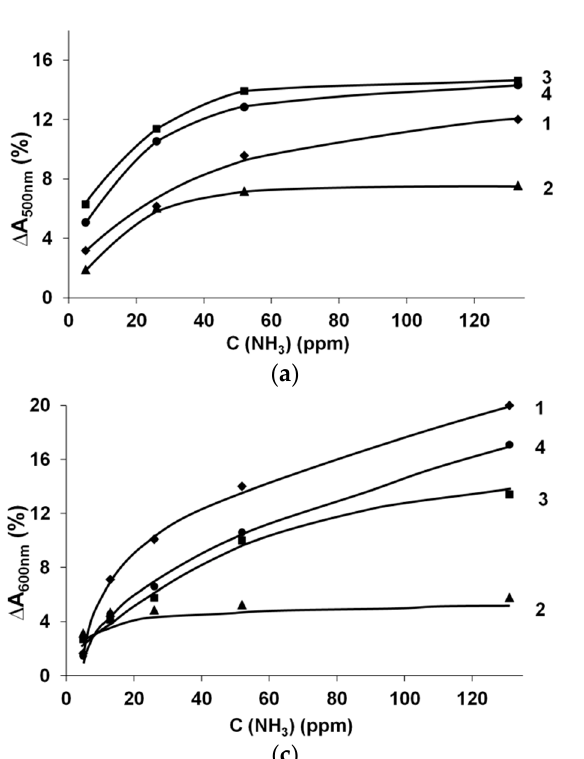
Figure 4. Dependence of response amplitude on the concentration of ammonia for the films of the PEDOT ( a ), PPy ( b ) and PANI ( c ) complexes with 1-PAMPSA, 2-PSSA, 3-i-PASA and 4-t-PASA.